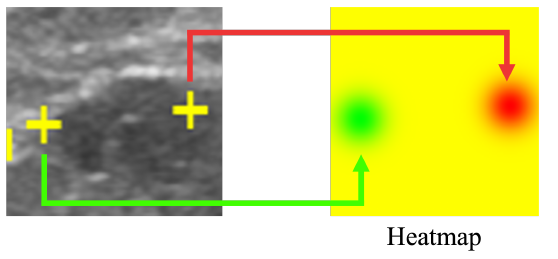
Figure 4. Saliency map showing the location of salient landmarks. The position of the left salient landmark is represented in green and the right one in